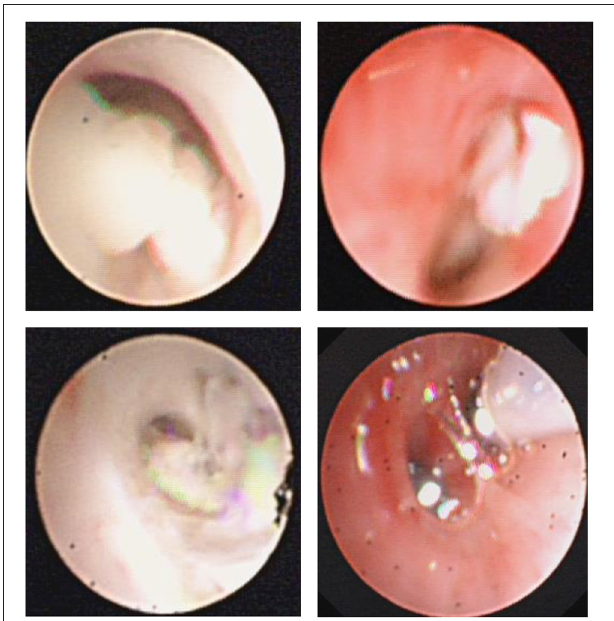
Frontiers in Pediatrics |